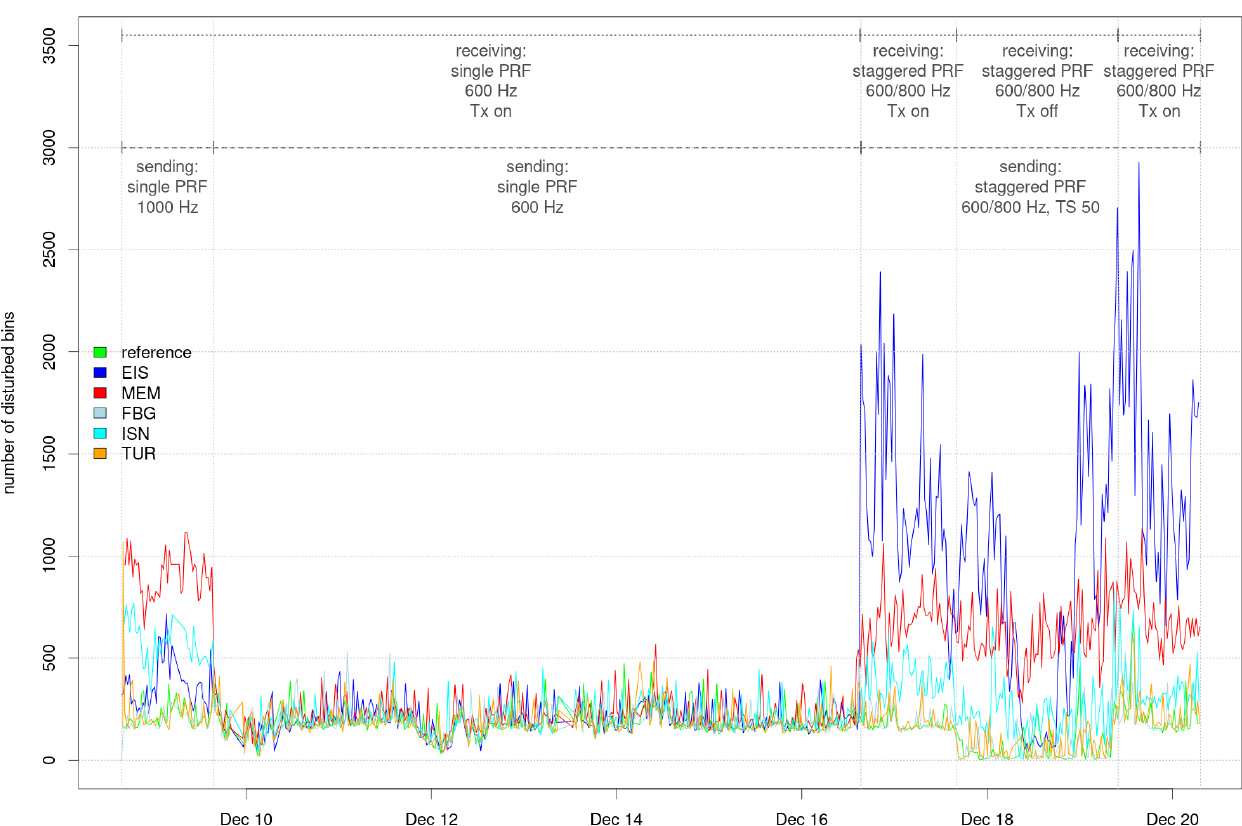
Figure 6. Time series of the number of pixels with an interference signal caused by the operational radars Eisberg (EIS), Memmingen (MEM), Feldberg (FBG), Isen (ISN) and Türkheim (TUR). Data from the radar Hohenpeißenberg (MHP) are evaluated to identify the interference signal. The dotted line at the top shows the periods of different settings on the receiving MHP radar, the dashed line those of the transmitting